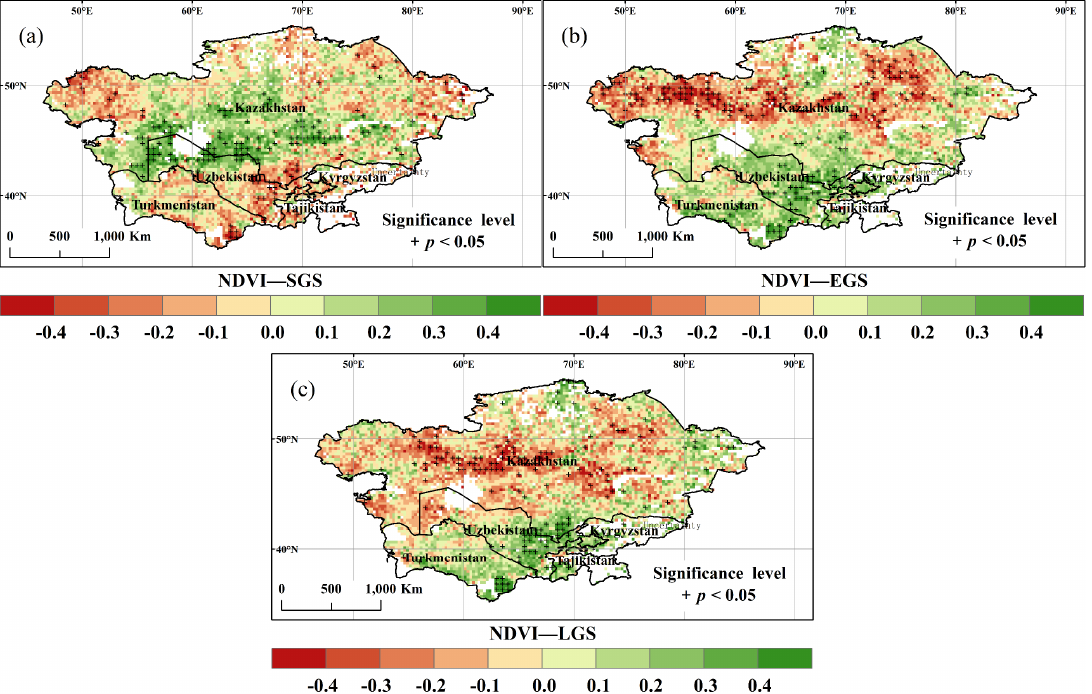
Figure 12. Spatial distribution of correlations between annual NDVI and ( a ) SGS, ( b ) EGS, and ( c ) LGS from 1982–2014.